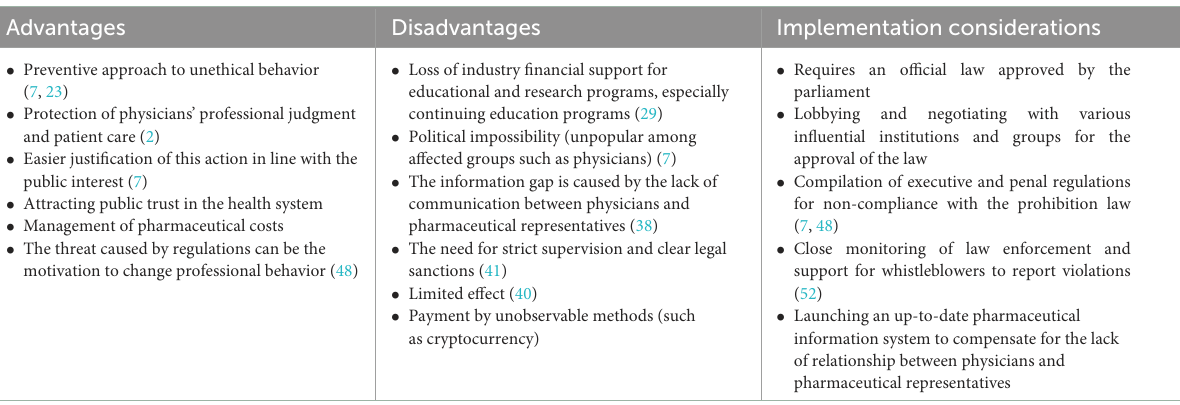
TABLE 3 Advantages, disadvantages, and implementation considerations of policy options: 1. Prohibition.